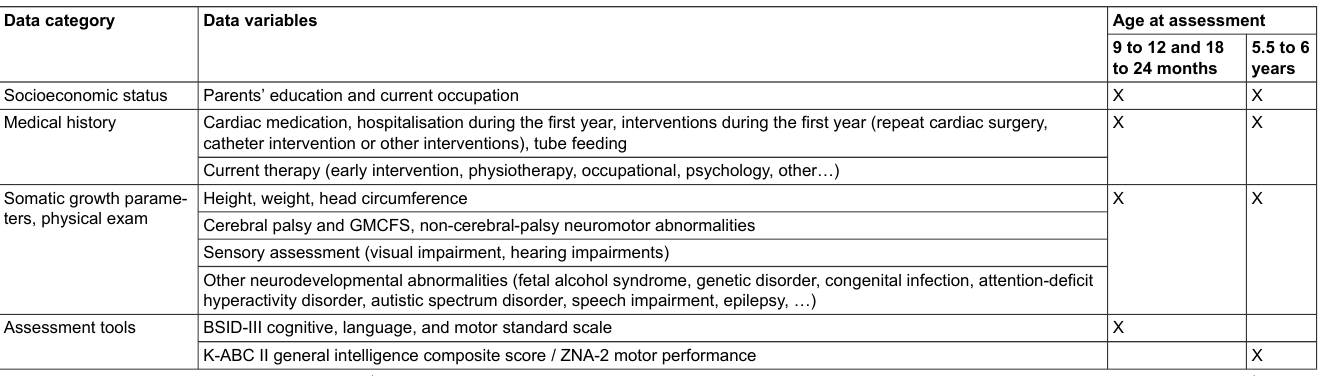
Table 4: Neurodevelopmental outcome variables of ORCHID.